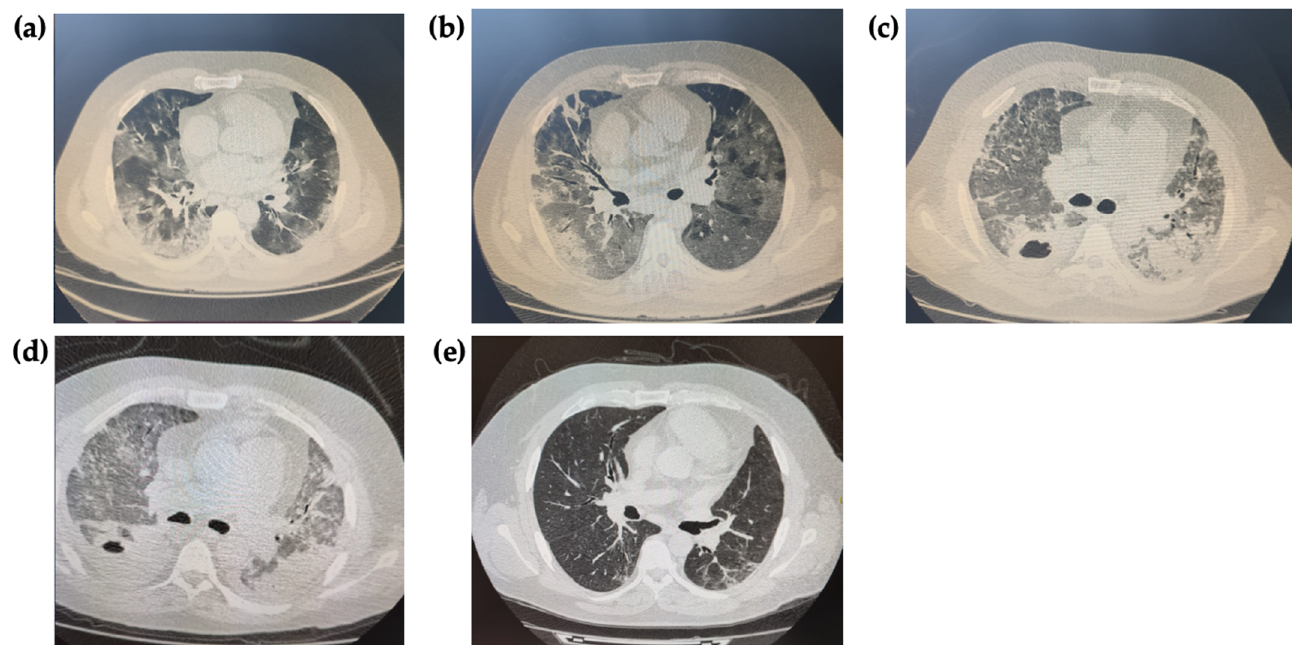
Figure 2. ( a ) Day 3. Bilateral polysegmental infiltration (ground glass opacity), a high probability of viral origin of pneumonia with involvement of lung parenchyma from 50 to 75%; ( b ) Day 7. An increase in involvement of parenchyma of both lungs up to 75% due to ground glass type interstitial infiltration, the appearance of perivascular and subpleural consolidation lesions in the right lung; ( c ) Day 35. An increase of the parenchyma infiltration of both lungs due to ground glass opacity up to 95%, previously non-visualized limited air cavity in S 6 of the right lung with thick uneven walls, with a fluid level in the lumen (45 × 30 × 36 mm), most likely corresponding to lung abscess; ( d ) Day 58. The trend towards a decrease in size of destructive cavity; ( e ) Follow up chest CT 2.5 months after the hospital discharge. Residual post-inflammatory changes in the form of reticular changes, single bullae up to 8 mm in diameter.